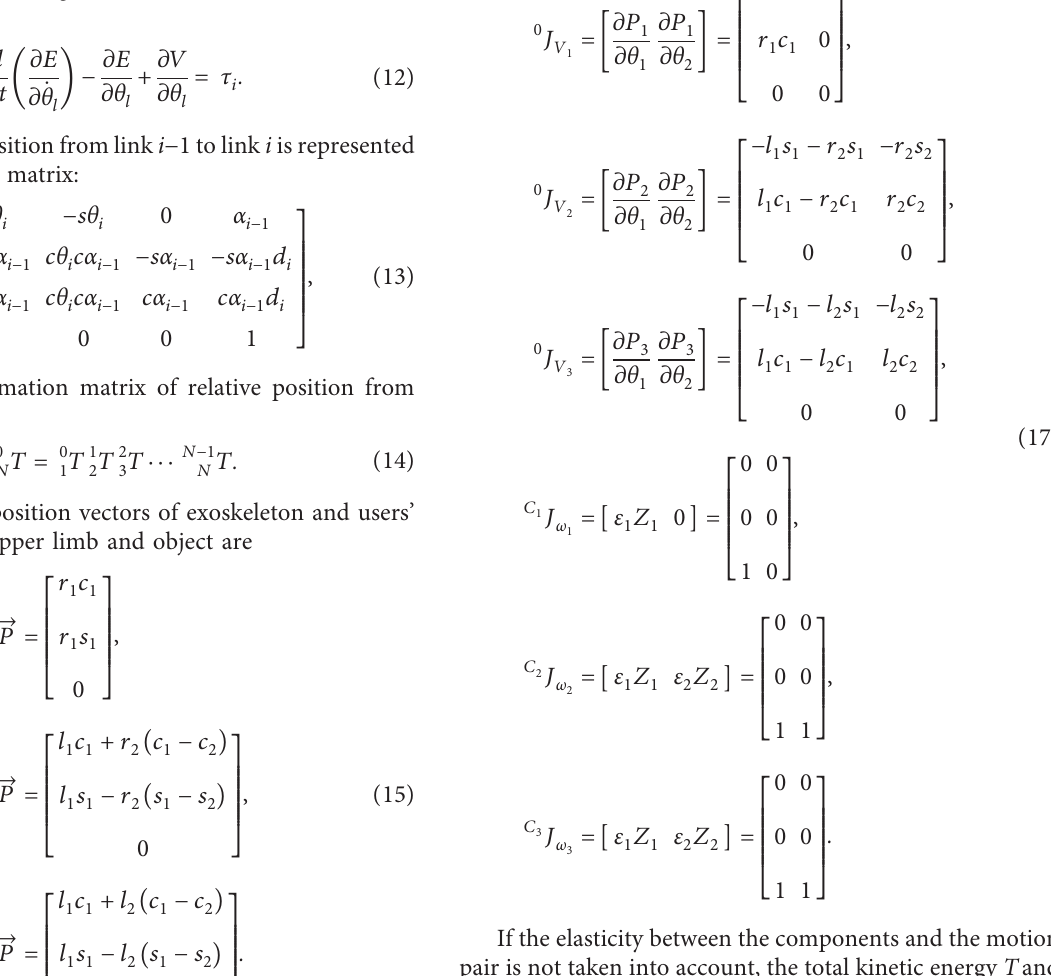
Figure 7: The users’ upper limbs, arms, and hands are simplified. Withreference to Figure 2, pointO is selectedas theorigin to establish an x o -y o Cartesian coordinate system; m 1 is the mass of the upper limbs and exoskeleton; l 1 is the length of the exoskeleton; m 2 is the mass of the arm; l 2 is the length of the arm; m 3 is the mass of the